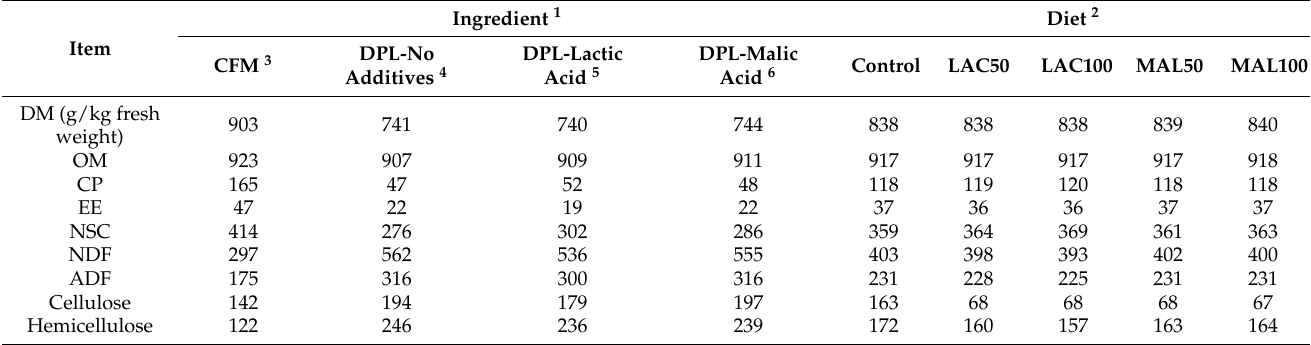
Table 1. Chemical composition of ingredients and diets (g/kg DM) fed to lactating ewes.